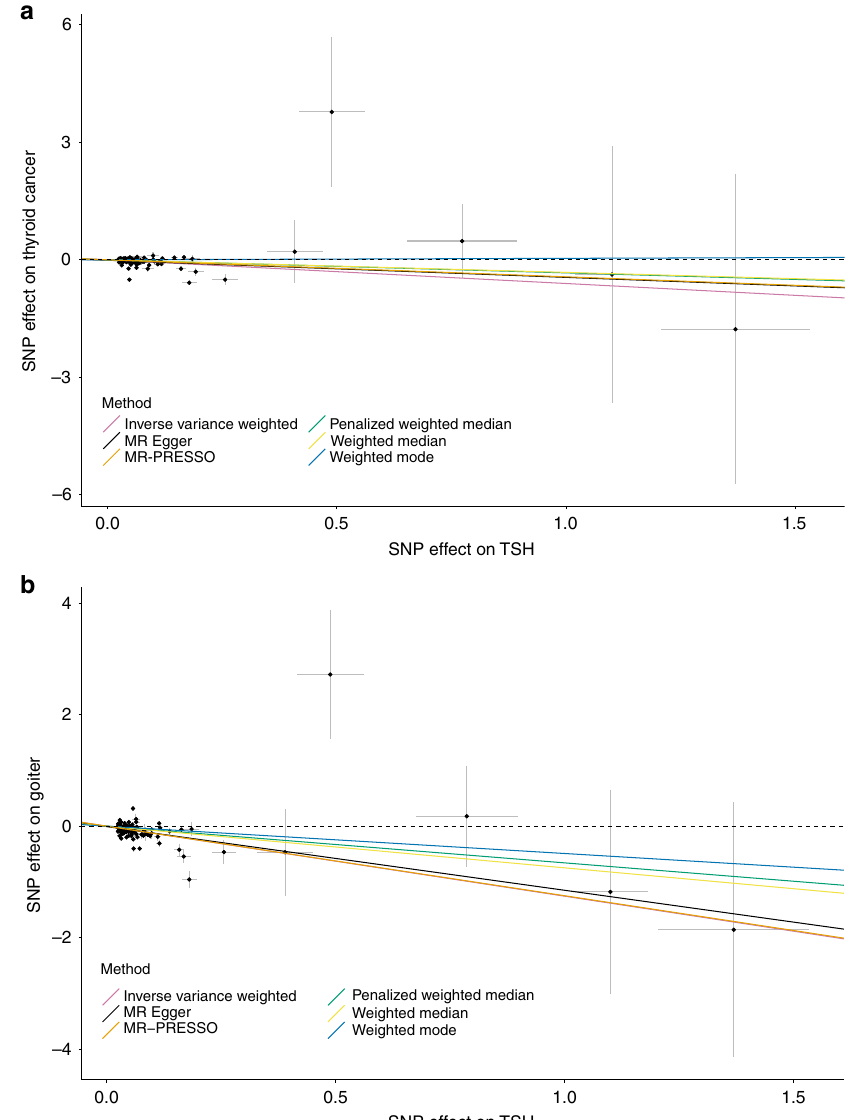
Fig. 3 Two-sample Mendelian randomization analysis for casual associations between TSH and thyroid cancer and between TSH and goiter. a . Two- sample MR between TSH and thyroid cancer based on summary statistics from the meta-analysis of HUNT and ThyroidOmics ( n = 106,360) for TSH and from the meta-analysis of UKBB 27,28 , MGI 26 , deCODE and four other case – control data sets with European ancestry as reported in Gudmundsson et al. 19 for thyroid cancer association (cases/controls = 4,146/731,903). b TSH and goiter based on summary statistics from the same TSH meta-analysis as above and from the GWAS of UKBB 27,28 for goiter association ( N case = 1,143, N control = 391,429) The crosshairs on the plots represent the 95% con fi dence intervals for each SNP-TSH or SNP-outcome association. The variant on the top left corner is the rare nonsynonymous variant B4GALNT3 p. R724W (rs145153320). N : sample size. N case: sample size of cases. N control: sample size of